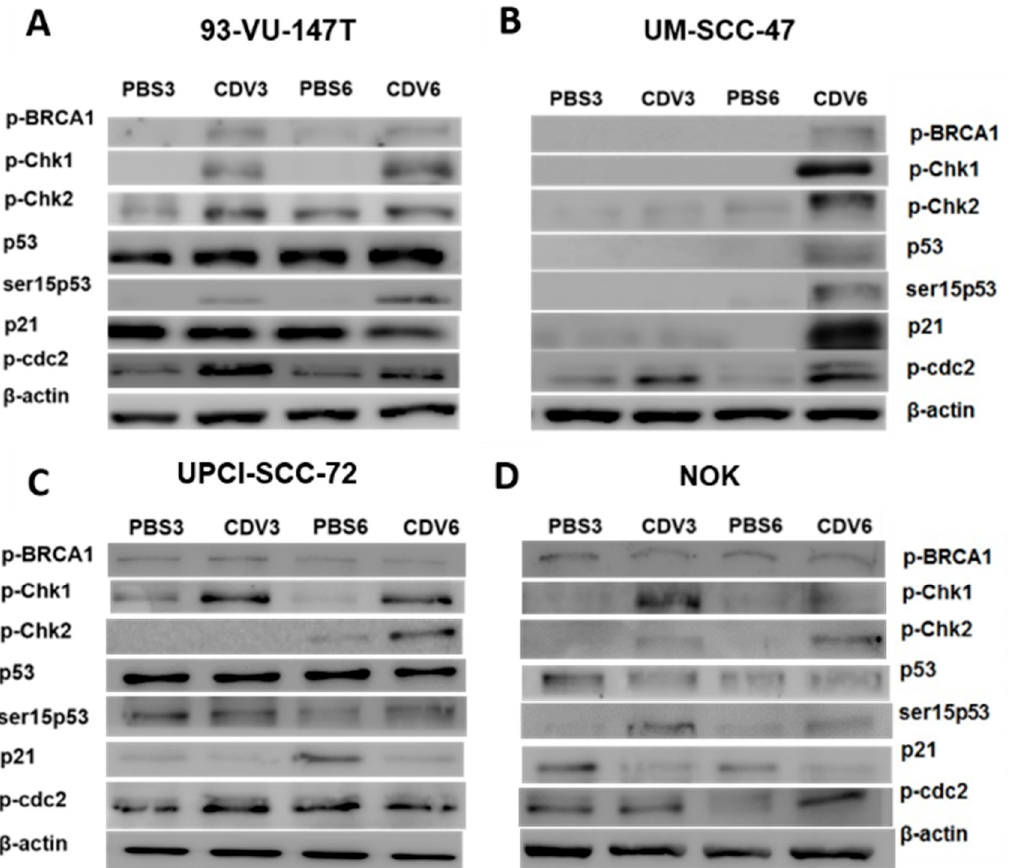
Figure 3. Expression levels of proteins involved in the DNA damage response pathway by western blot analysis of whole protein extracts. The cells were treated for 3 and 6 days with the IC 50 value of CDV or control (PBS). β -actin was used as loading control. For the cell lines ( A ) 93-VU-147T and ( B ) UM-SCC-47 protein extracts of 10 µ g were used, where for ( C ) UPCI-SCC-72 and ( D ) NOK protein extracts of 30 µ g were used. The experiments were performed in